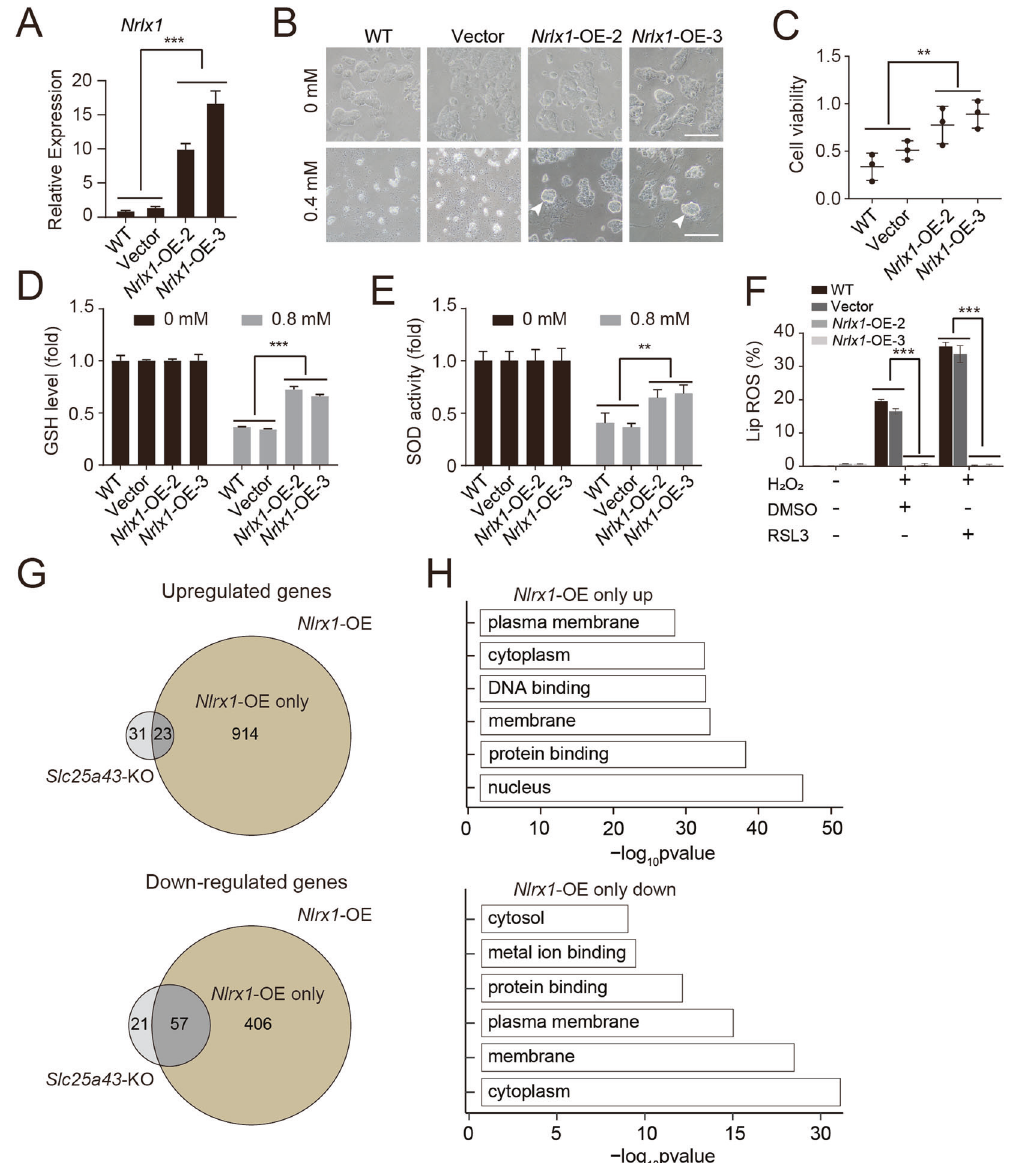
Fig. 6 Overexpression of Nlrx1 suppressed H 2 O 2 -induced oxidative stress. A The expression levels of Nlrx1 in Nlrx1 -OE-2 ESCs, Nlrx1 -OE-3 ESCs, empty vector-transfected ESCs and WT-diESCs according to qPCR. The data represented those of three independent experiments ( t- test; *** p < 0.001). The data were presented as the means ± SDs. B Phase-contrast images of Nlrx1 -OE ESCs, empty vector-transfected ESCs and WT- diESCs after treatment with 0.4 mM H 2 O 2 for 4 h. Scale bar, 100 μ m. C Cell viabilities of Nlrx1 -OE ESCs, empty vector-transfected ESCs and WT- diESCs treated with 0.4 mM H 2 O 2 for 4 h. The data represented those of three independent experiments ( t- test; ** p < 0.01). The data were presented as the means ± SDs. D GSH levels in Nlrx1 -OE ESCs, empty vector-transfected ESCs and WT-diESCs treated with/without 0.8 mM H 2 O 2 for 4 h. The data represented those of three independent experiments ( t- test; *** p < 0.001). The data were presented as the means ± SDs. E SOD activities in Nlrx1 -OE ESCs, empty vector-transfected ESCs and WT-diESCs treated with/without 0.8 mM H 2 O 2 for 4 h. The data represented those of three independent experiments ( t- test; ** p < 0.01). The data were presented as the means ± SDs. F Lipid ROS production in Nlrx1 -OE ESCs, empty vector-transfected ESCs and WT-diESCs treated with 0.8 mM H 2 O 2 in the presence or absence of RSL3 (1 μ M) for 4 h, as assessed via fl ow cytometry analysis together with C11-BODIPY staining. The data represented those of three independent experiments ( t- test; *** p < 0.001). The data were presented as the means ± SDs. G Venn diagram of the overlapping genes between Slc25a43 -KO ESCs and Nlrx1 -OE ESCs (including upregulated and downregulated genes) upon treatment with H 2 O 2 . The dark gray circle represents the overlapping upregulated DEGs or downregulated DEGs between Slc25a43 -KO ESCs and Nlrx1 -OE ESCs. The brown region represented only the upregulated or downregulated DEGs in Nlrx1 -OE ESCs. H GO analysis of only the upregulated and downregulated genes in Nlrx1 -OE ESCs compared to Slc25a43 -KO ESCs and WT-diESCs upon treatment with H 2 O 2 . comprehensively understand the effects of Slc25a43 -KO, we stress described previously was correlated with mitochondrial identi fi ed the top 10 upregulated genes (Fig. S5C) and the top function, [39] the cell cycle [40] and peroxiredoxin [41]. Here, we 10 downregulated genes (Fig. S5D) among the DEGs. As shown in assessed the relationships of DEGs with these three aspects. There the list, the signi fi cantly upregulated genes ( Rnf26 , Rpl29 and were several oxidative stress DEGs related to mitochondrial Nlrx1 ) and the markedly downregulated genes ( Rgcc and Casr ) in function instead of the cell cycle and peroxiredoxin (Fig. 5B). To Cell Death and Disease (2022)